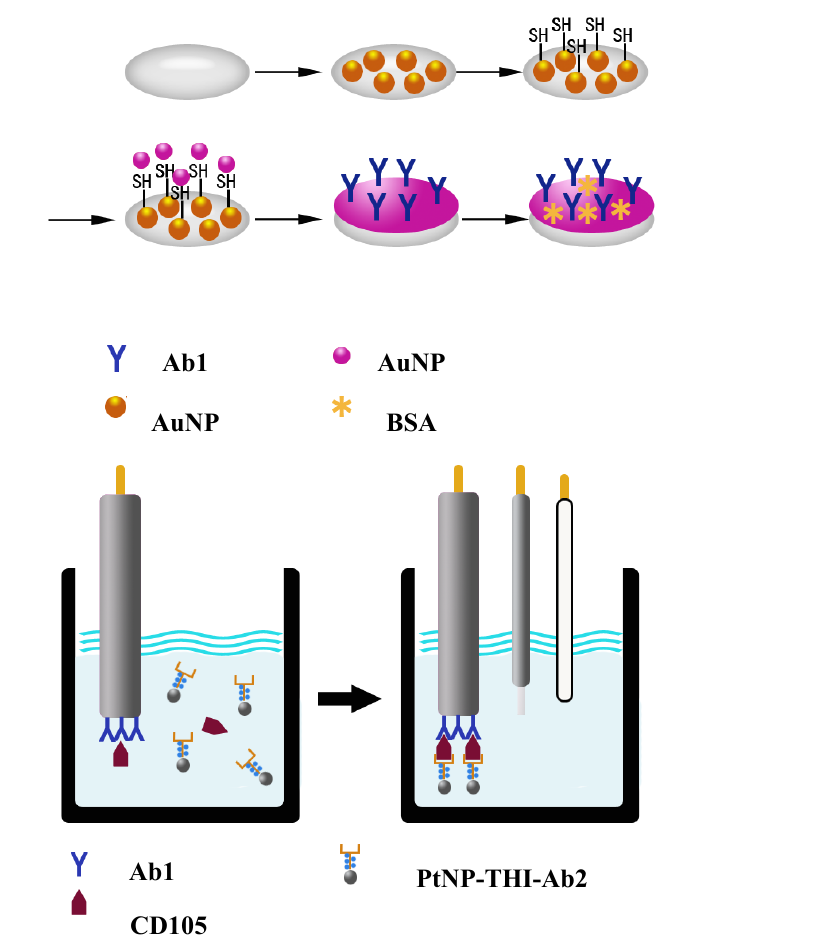
Figure 1. Diagram of the measurement and regeneration procedures of the proposed